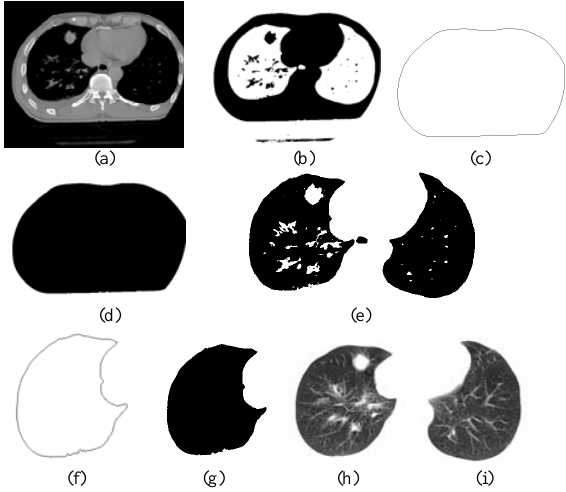
Fig. 3. Extraction processes of pulmonary parenchyma. (a)original image, (b)threshold segmentation of thorax, (c) contour track of thorax, (d)thorax mask, (e)threshold segmentation of pulmonary parenchyma, (f)contour of right lung, (g)mask of right lung, (h)right lung, (i)left lung